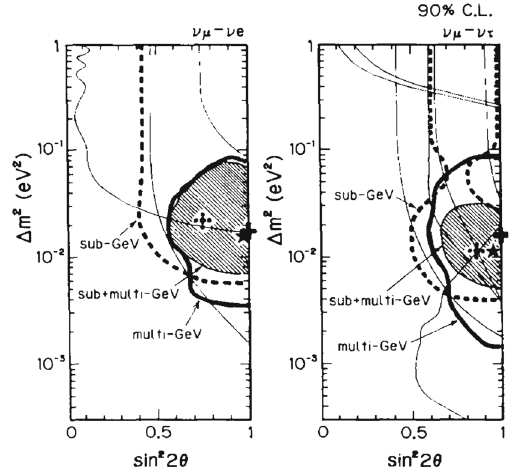
Fig. 8 The 90% CL allowed neutrino-oscillation parameters as obtainedfromthemulti-GeVdata(thickcurves).Theallowedregionsas Earth obtained from the sub-GeV data are also shown by thick-dotted curves. The allowed regions as obtained by combining the sub- and multi-GeV data are also shown (shaded region). The best fit values are also shown bydash-crosses(sub-GeVdata),full-crosses(multi-GeVdata)andstars (sub- and multi-GeV data combined). The 90% CL excluded regions from the other experiments are also shown